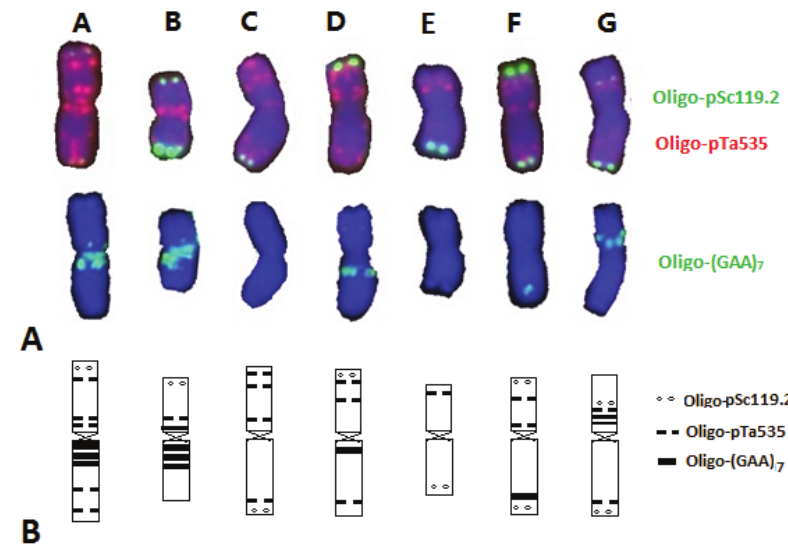
Figure 2. Karyotype ( A ) and ideogram ( B ) of D. breviaristatum chromosomes presents in the wheat— D. breviaristatum partial amphiploid